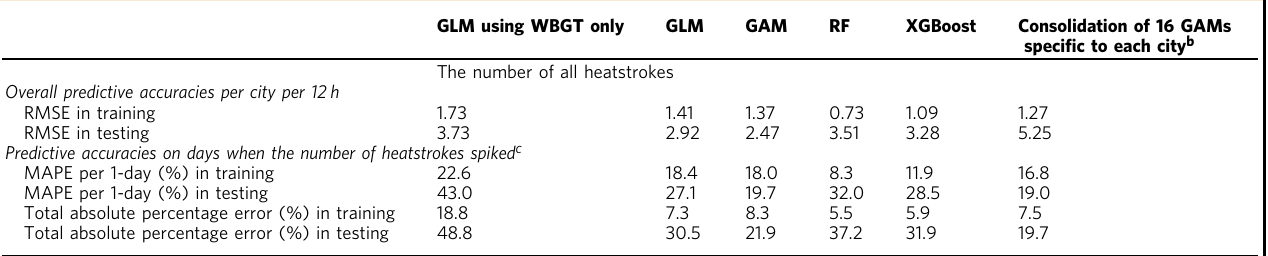
Table 2 Prediction performances of prediction models for the number of all heatstrokes among 6 models a